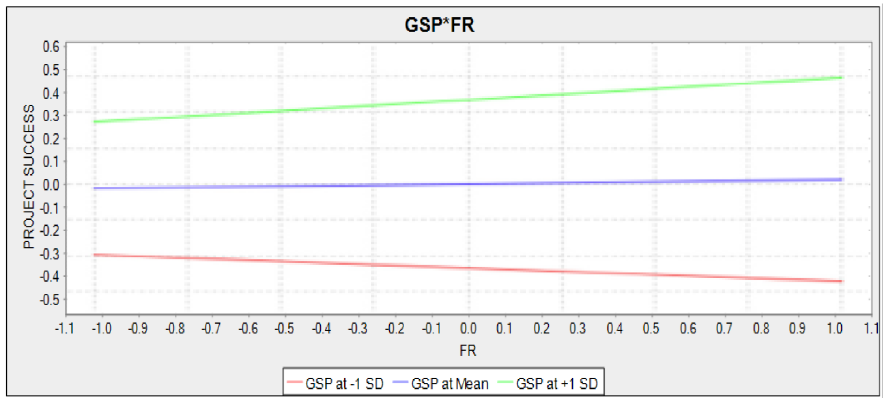
Figure 5. Moderating effect of government support on the effect of financial risk factors on project success.